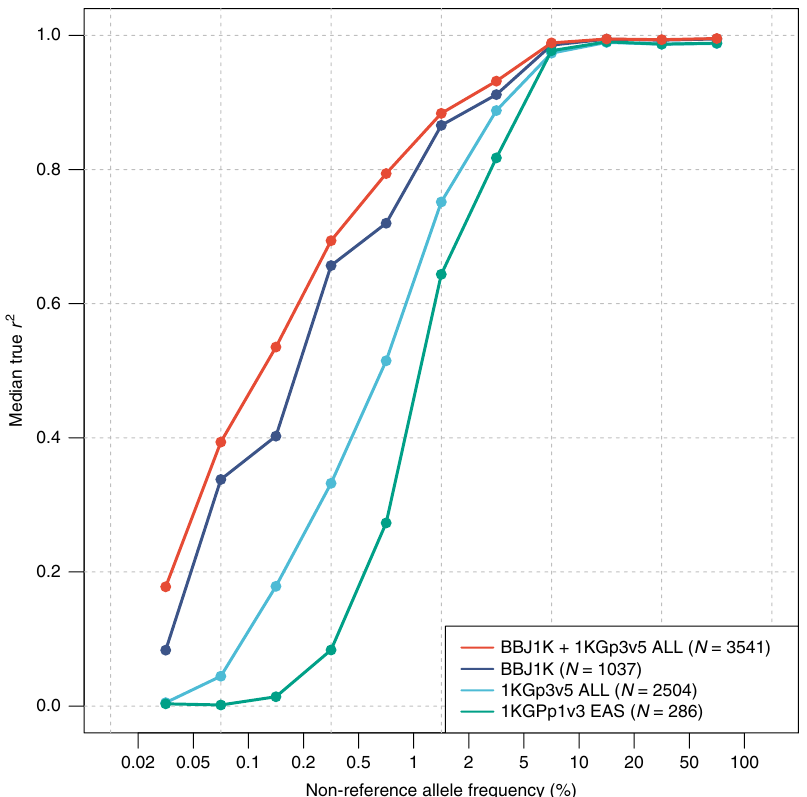
Fig. 1 Plot of imputation qualities by different reference panels. The accuracy of imputation was evaluated for four different reference panels at “ masked ” HumanExome SNPs. BBJ1K + 1KGp3v5 panel (red) showed the best performance at every allele frequency bins. Even the BBJ1K panel showed much better accuracy than the 1KGp3v5 ALL panel regardless of the difference in sample size, indicating the contribution of deep haplotype information of the speci fi c population to imputation accuracy. Median r 2 values are shown on the y